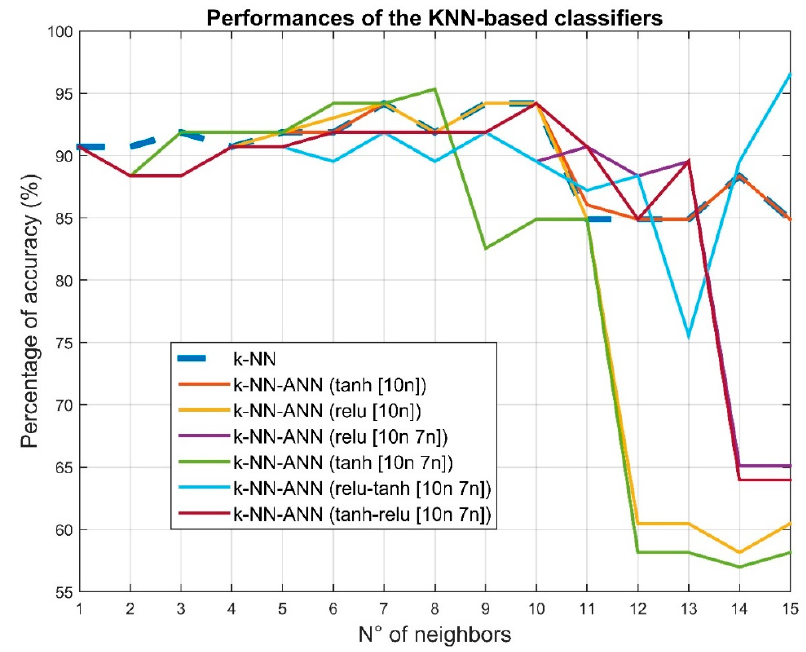
Figure 5. Accuracies of k-NN and the different ANNs structures for the combined method. Among square brackets the number of neurons per layer is indicated; tanh denotes the hyperbolic tangent sigmoid activation function, relu is rectified linear unit function.